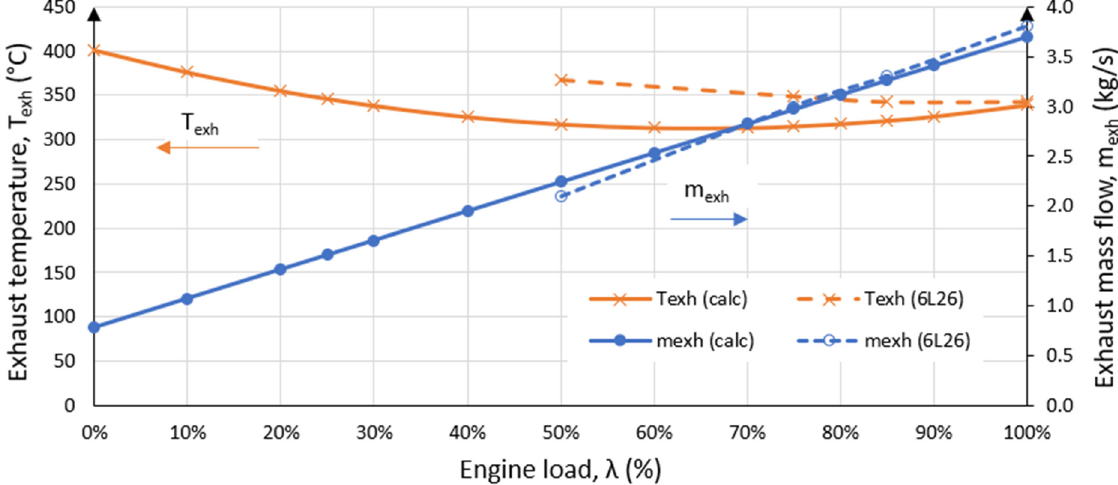
Figure 9. Comparison for exhaust mass flow and temperature between those calculated and listed in the engine guide. the engine guide.